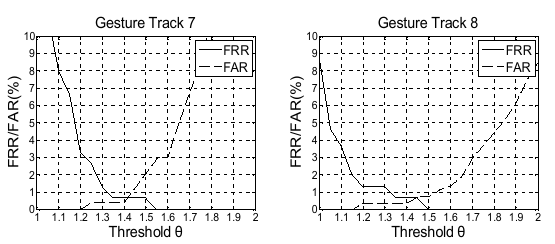
Figure 8. Gesture Data after Normalization Figure 9. The Relationship between Misjudgment Rate and Threshold of Eight Gesture Tracks